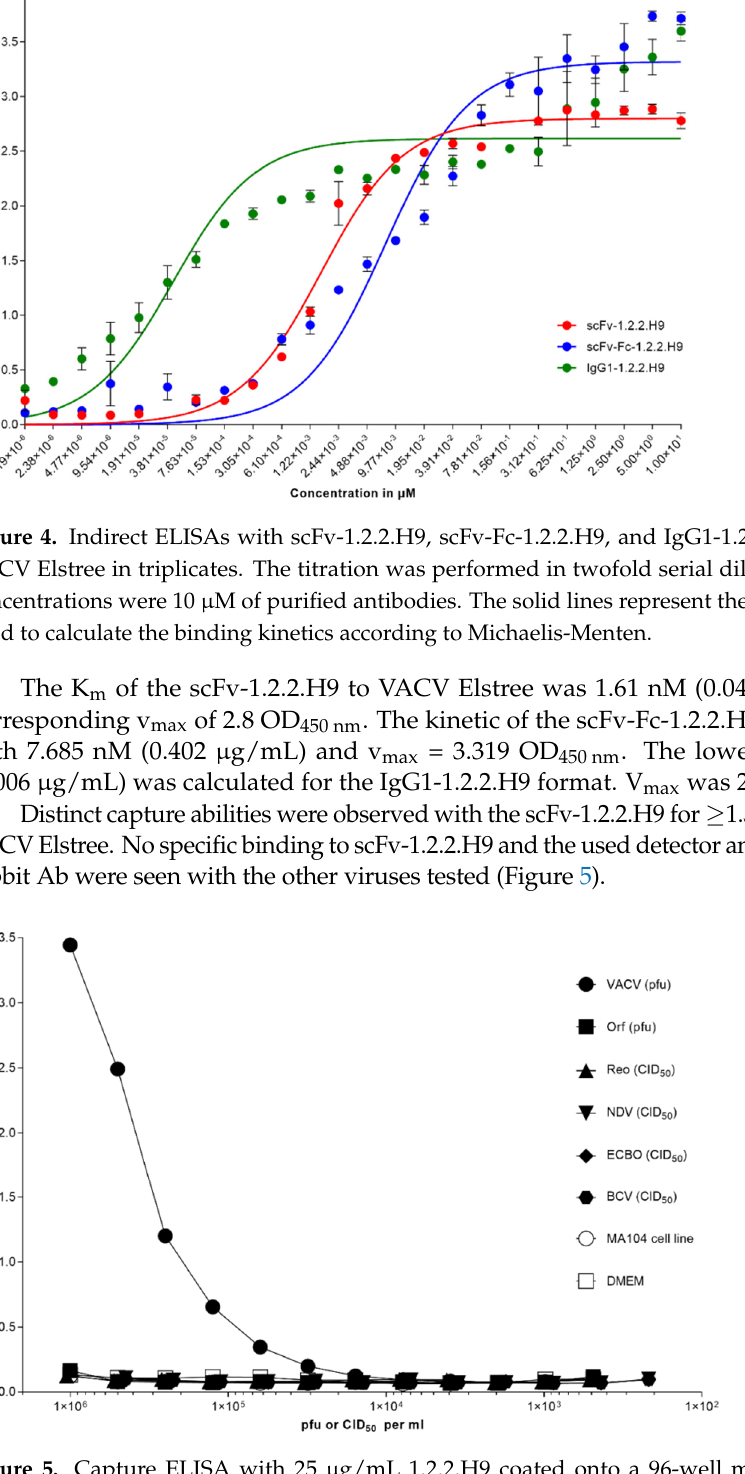
Figure 5. Capture ELISA with 25 µg/mL 1.2.2.H9 coated onto a 96-well microtiter plate. Different virus strains received from cell-cultured material were tested: 10 6 pfu/mL vaccinia virus Elstree (VACV), 10 6 pfu parapoxvirus orf D1701 (Orf), 10 6.75 CID 50 /mL bovine coronavirus V270 (BCV), 10 7.625 CID 50 /mL reovirus (Reo), 10 7.25 CID 50 /mL Newcastle disease virus (NDV), and 10 7.25 CID 50 /mL enterocytopathogenic bovine orphan virus (ECBO). Negative controls were MA104 cell line and DMEM. The titrations were conducted in twofold serial dilutions. Specific binding was detected using anti-MVA-polyclonal rabbit Ab